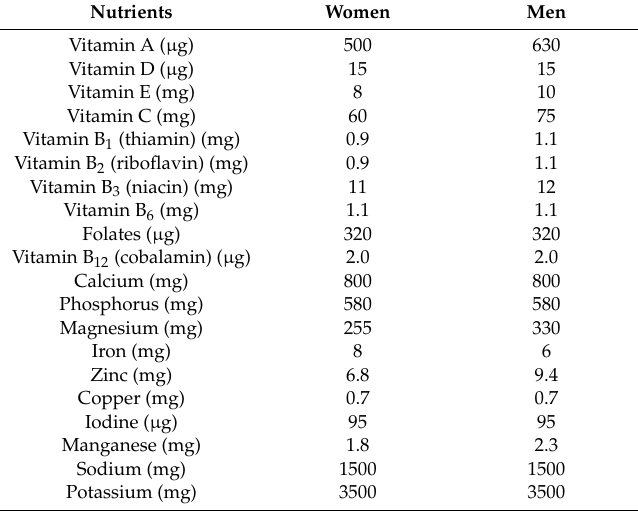
Table 1. Nutrient norms for men and women over 19 years of age, determined on the basis of the EAR. Nutrients